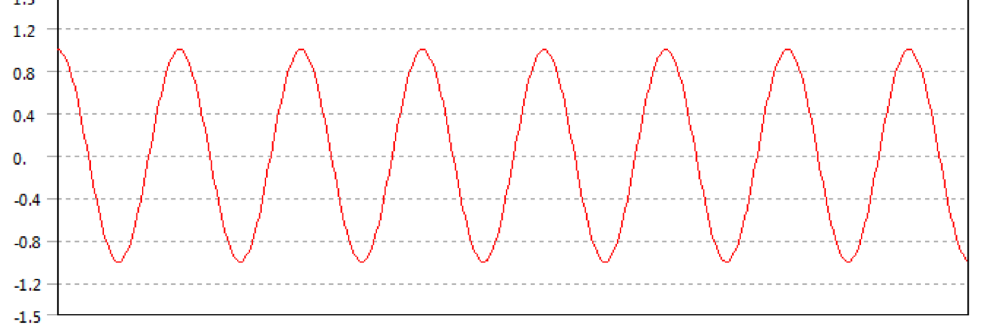
Fig. 5. Reversible loading.